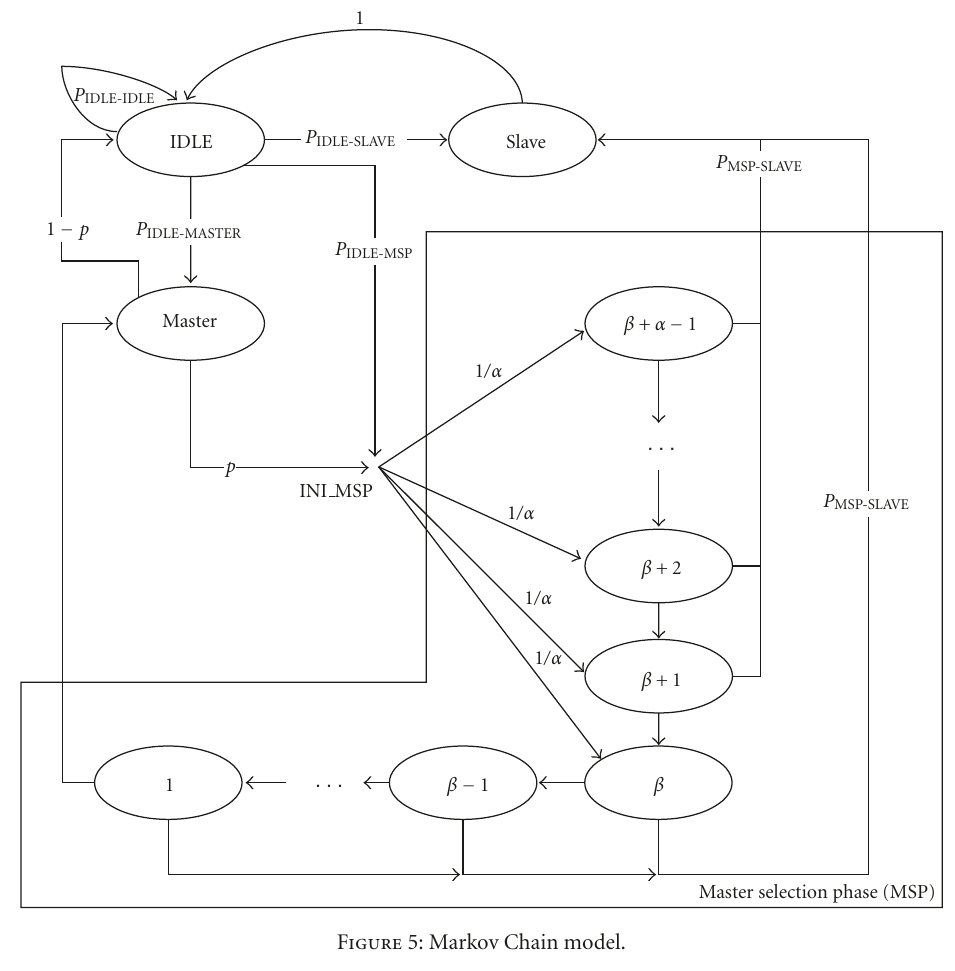
Figure 5: Markov Chain model.